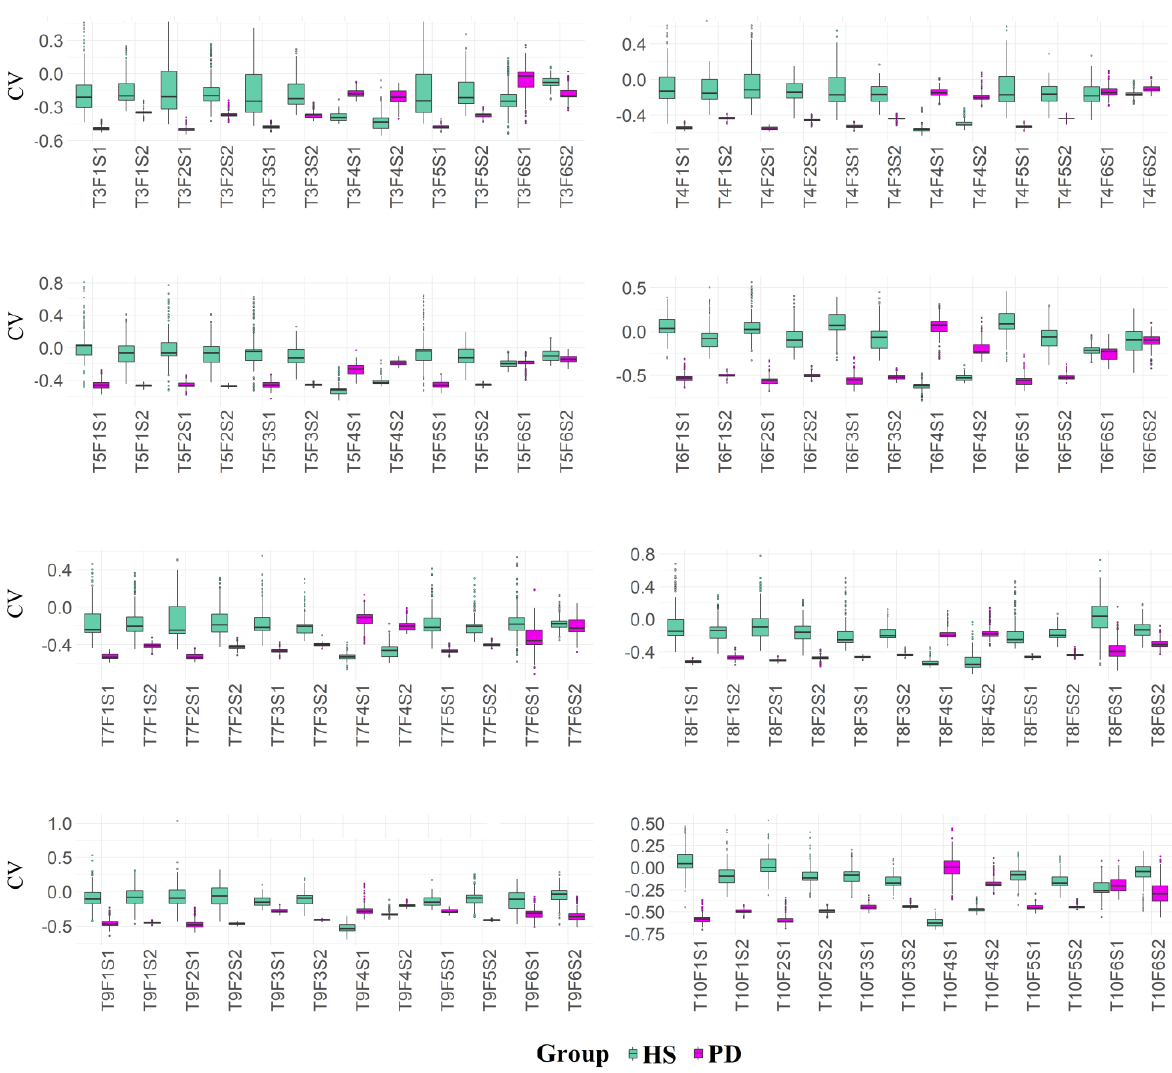
Figure 10. The top seven and three variables that contribute to data variability. ( A ) The top seven contributing variables to the radial-ulnar axis; ( B ) The top seven contributing variables to the prox- imal-distal axis; ( C ) The top three contributing variables to the radial-ulnar axis; and ( D ) The top three contributing variables to the proximal-distal axis.